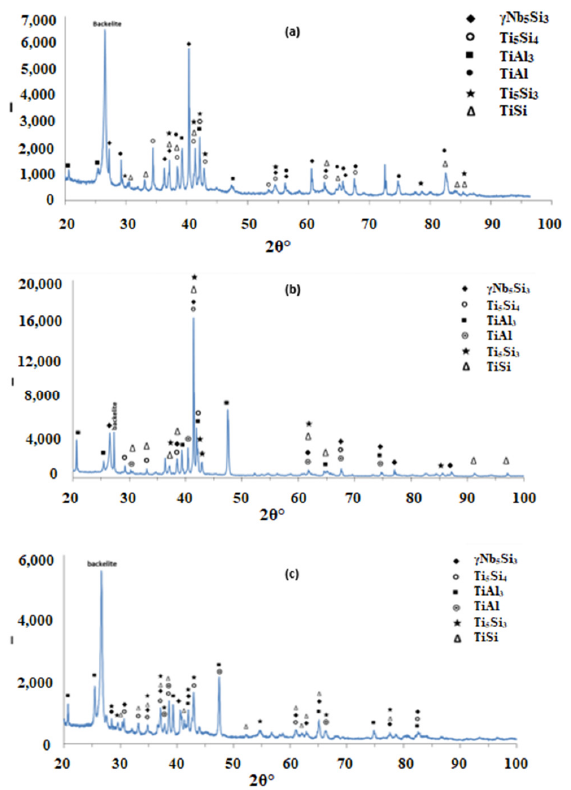
Figure 6. X ray diffractograms of the alloy Nb 1.3 Si 2.4 Ti 2.4 Al 3.5 Hf 0.4 ( a ) as cast; ( b ) heat treated at 800 °C; ( c ) heat treated at 1200 °C.